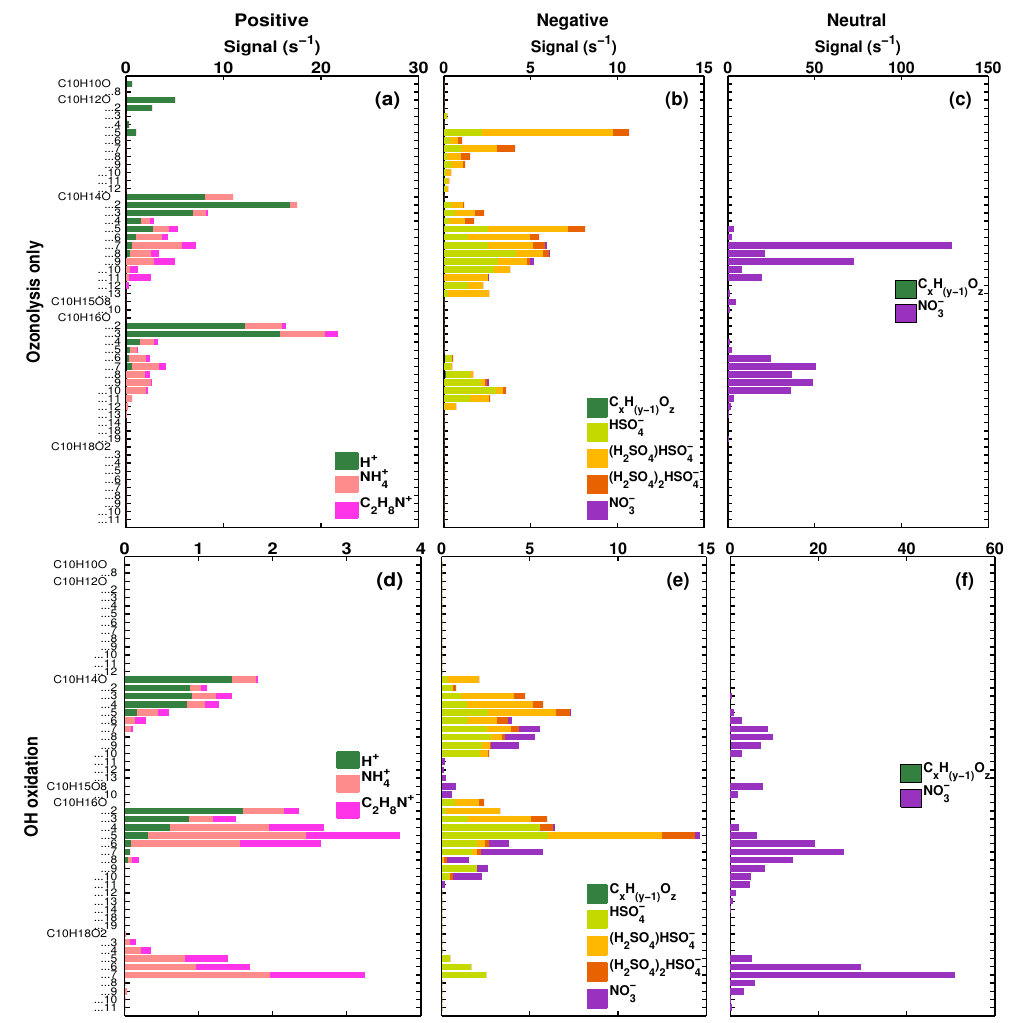
Figure 4. Stacked peak area for observed clusters containing C 10 H b O c according to core ion(s) of positive ( a and d ), negative ( b and e ), and neutral ( c and f ) clusters obtained from α -pinene ozonolysis with OH scavenger ( a – c ) and α -pinene oxidation by OH only ( d – f ).